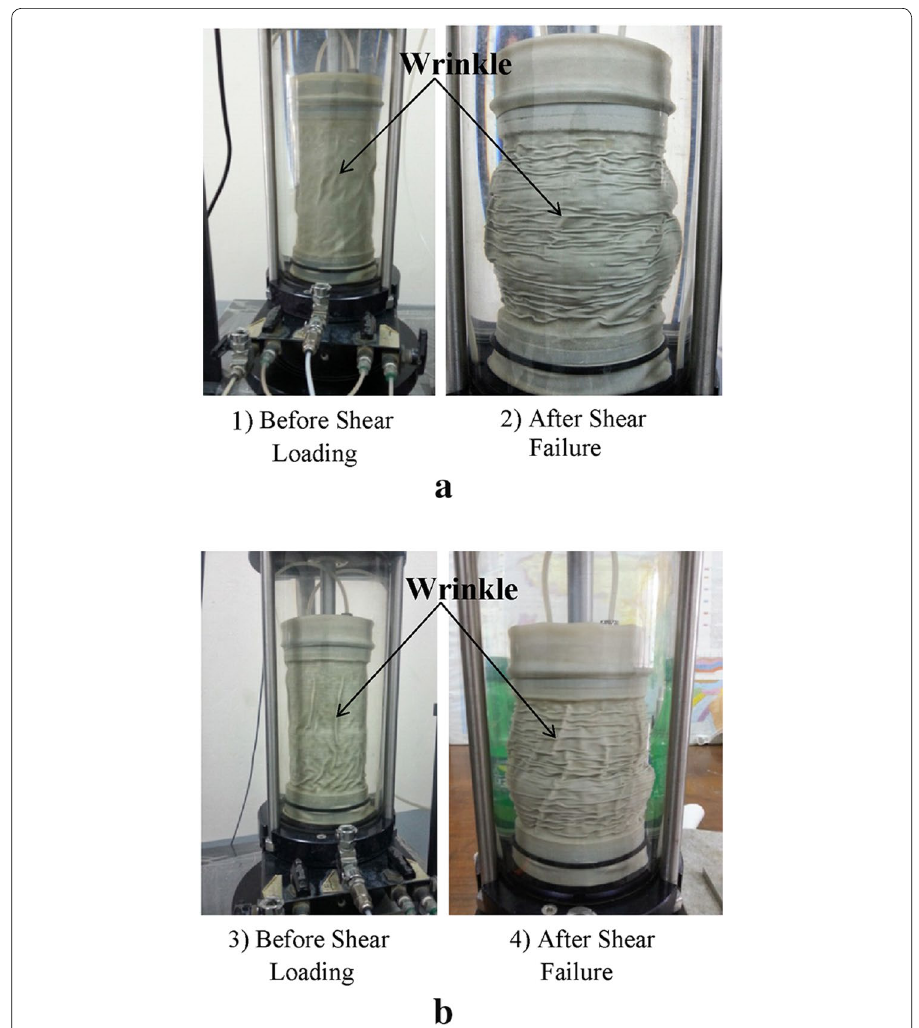
Fig. 5 Photograph of a specimen with 60% silt content and b pure silt